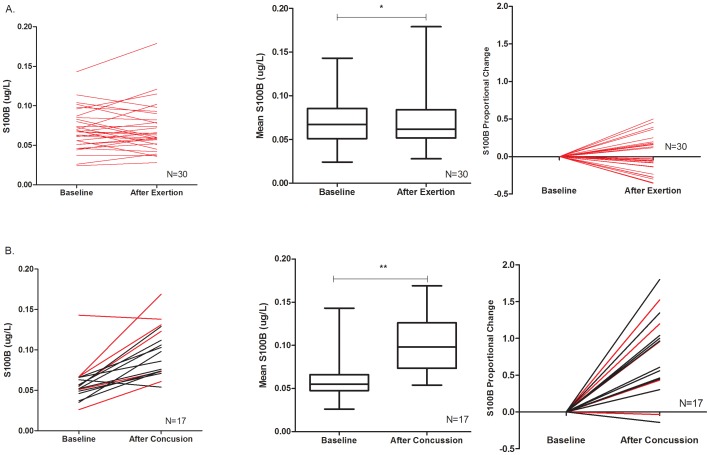
S100B Changes after non-contact exertion and sports-related concussion.
A: Absolute (Left) and proportional (right) changes in S100B levels after non-contact exertion among individal athletes. The proportional change is defined as (post-exertion or 3-hour post-SRC S100B – baseline S100B)/baseline S100B (range: −35% to +50%; mean proportional change  = +2.7%). The mean post-exertional S100B concentration (0.071±0.03 µg/L) was not significantly different from mean baseline (0.070±0.03 µg/L, *p = 0.87, Middle). B: Absolute (Left) and proportional (right) changes in S100B levels within 3 hours of SRC among individual athletes. The mean post-SRC S100B concentration within 3 hours of concussion (0.099±0.008 µg/L) was significantly higher than that at baseline (0.058±0.006 µg/L, **p = 0.0002, Middle). Proportional change (right) ranged from −14% to +180%; mean proportional change +81.2%). Munich athletes are designated in red, Rochester athletes in black.